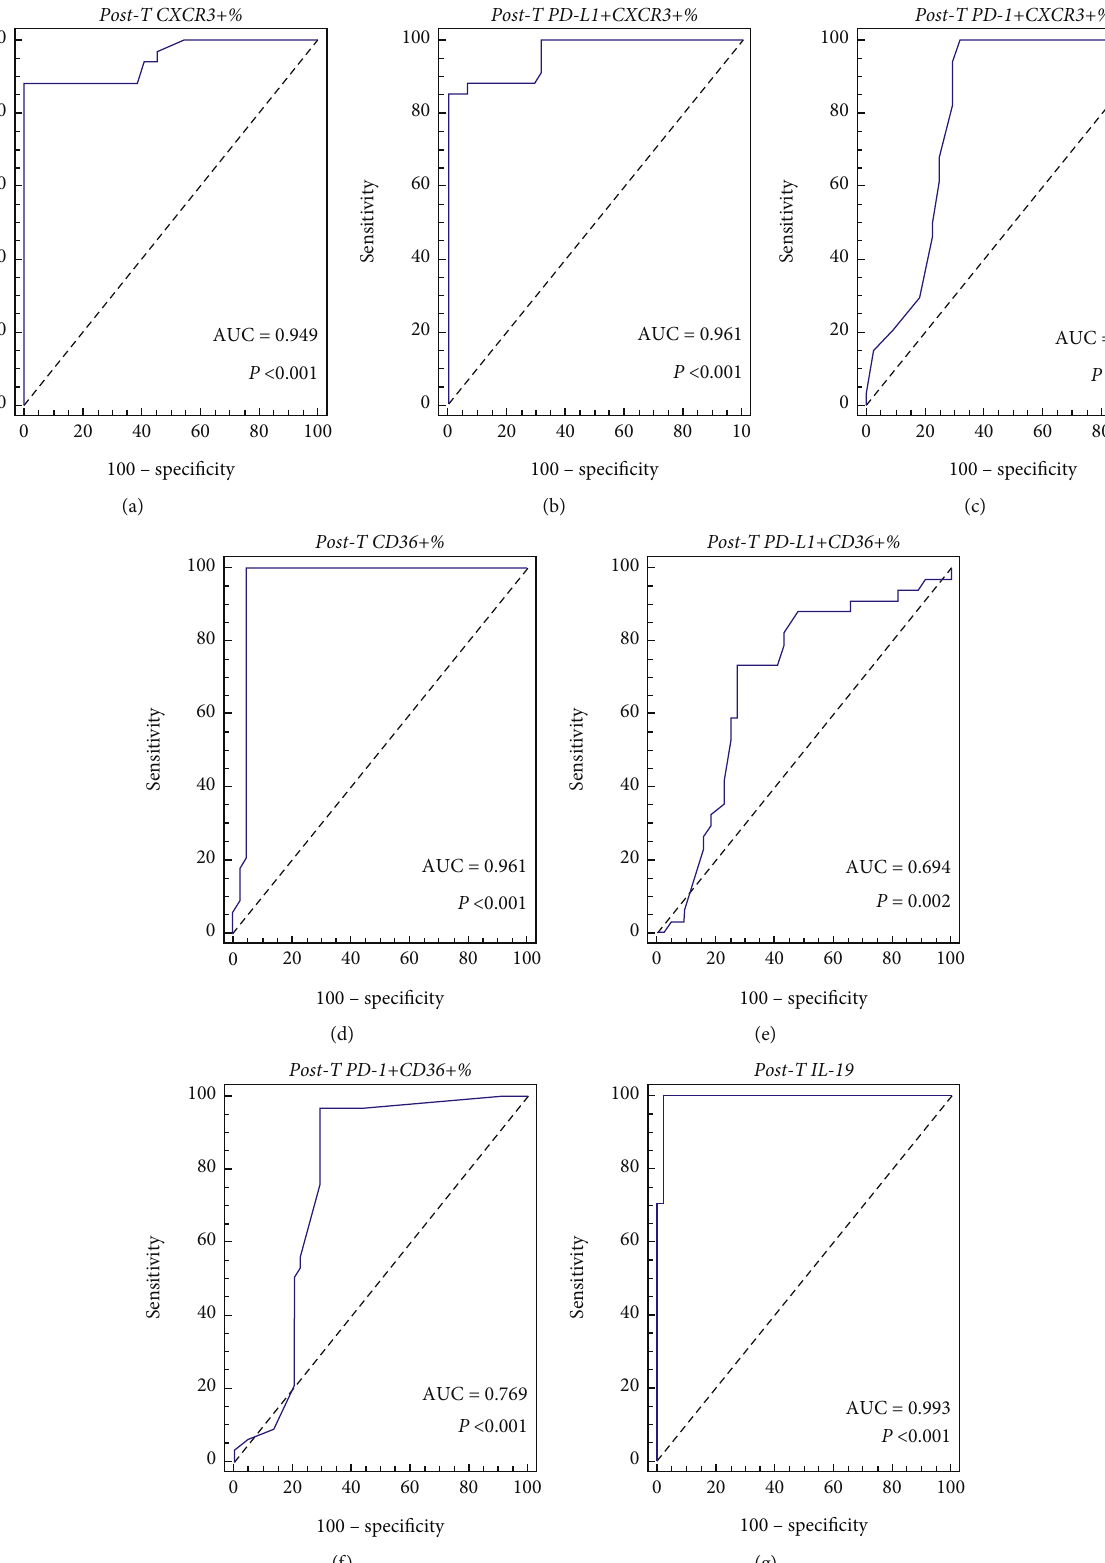
Figure 5: ROC curves of PD-L1/PD-1 coexpression with CXCR3/CD36 and IL-19 to diagnose extranodal involvement in lymphoma. (a) Posttherapy CXCR3+%. (b) Posttherapy PD-L1+CXCR3+%. (c) Posttherapy PD-1+CXCR3%. (d) Posttherapy CD36+%. (e) Posttherapy PD-L1+CD36%. (f) Posttherapy PD-1+CD36%. (g) Posttherapy